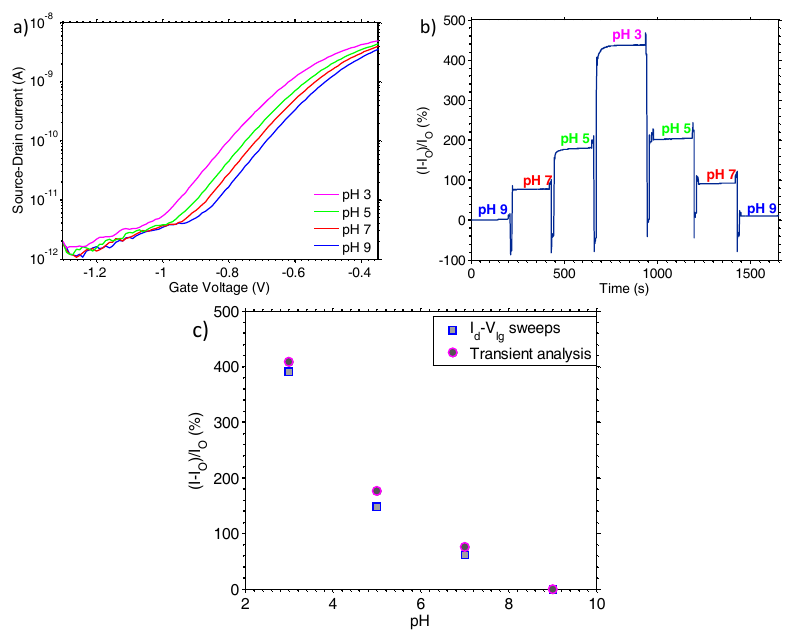
Figure 2. ( a ) Id-Vlg characteristic curves of the nanoribbon biosensor for a range of pH 3 to pH 9; ( b ) Normalised percentage drain current change of the biosensor for a range of pH from 3 to pH 9; ( c ) Nanoribbon biosensor pH sensitivity extracted from the Id-Vlg characteristic curves and transient measurements.